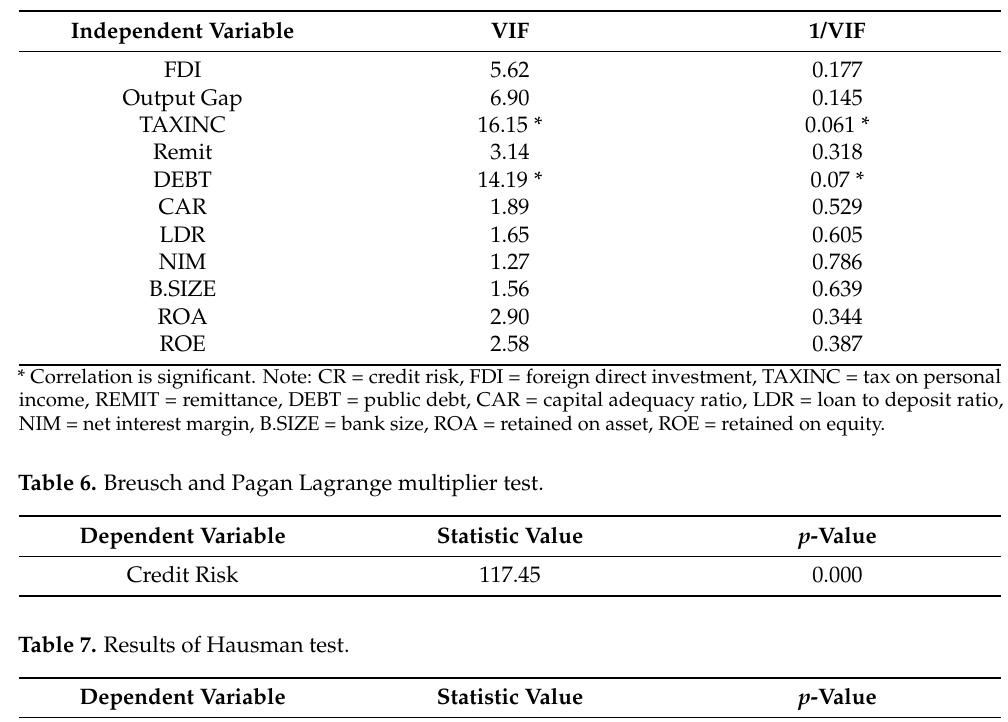
Table 5. Variance inflation factor (VIF).